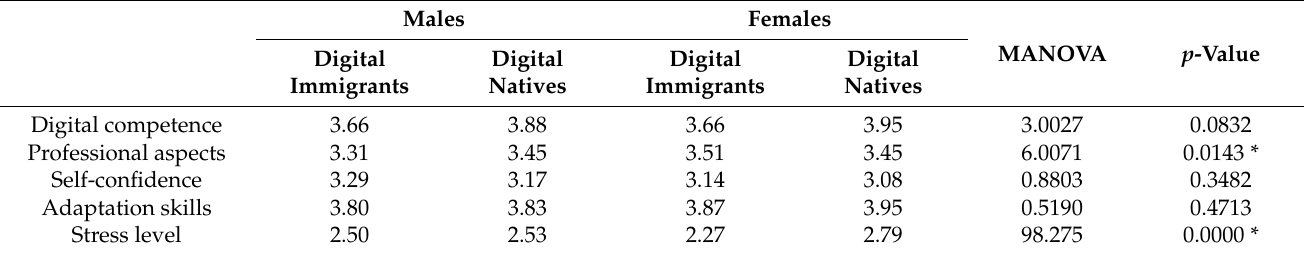
Table 12. Mean values of the subscales of the survey differentiating by digital generation and gender and statistics of the MANOVA test (mean values out of five). Males Females